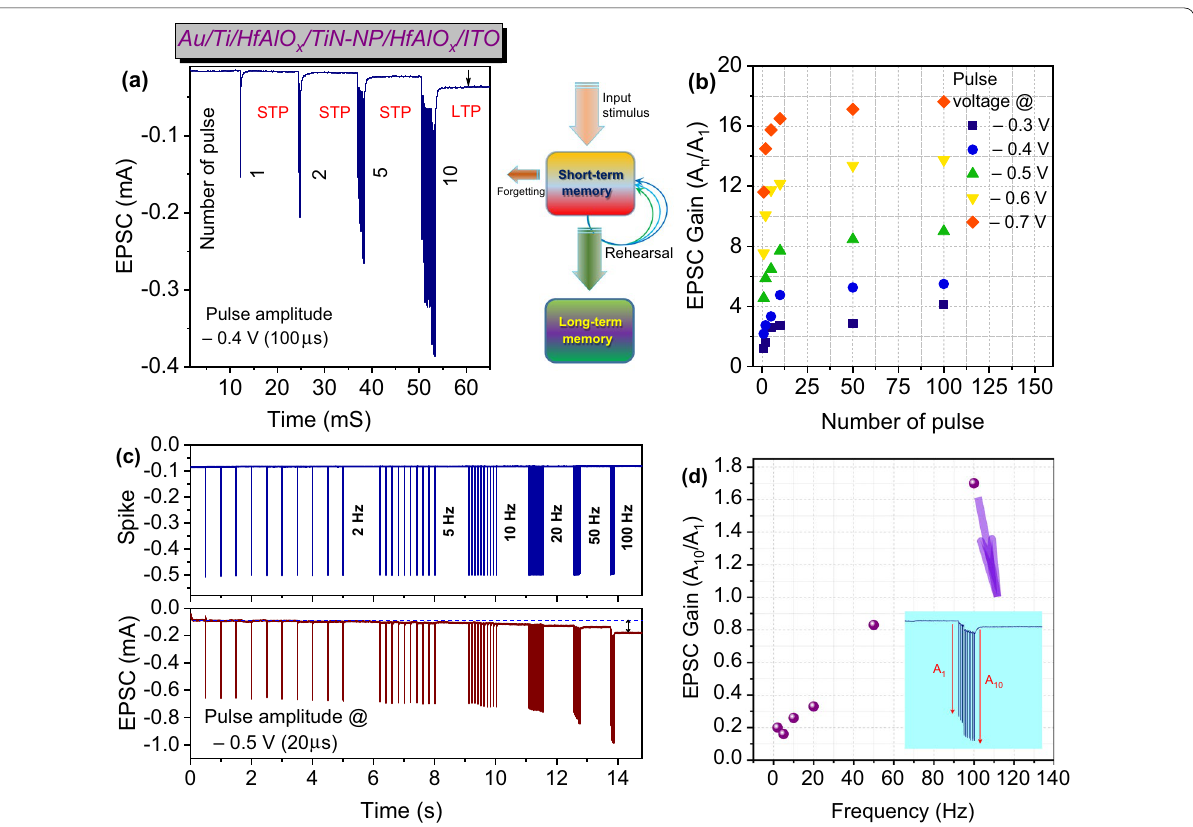
Fig. 4 a Transition from STM to LTM of Au/Ti/HfAlO x /TiN-NP/HfAlO x /ITO RRAM device with the change of EPSC varying the spike number from 1 to 10 at the pulse voltage amplitude of ‒ 0.4 V/100 µs, along with the schematic of memory enhancement by repeated pulses. b EPSC gain (A n /A 1 ) plotted w.r.t. the pulse number at different pulse voltage from ‒ 0.3 V/100 µs to ‒ 0.7/100 µs V. c Synaptic plasticity EPSC measured with frequency from 2 to 100 Hz and d the EPSC gain (A 10 /A 1 ) at pulse amplitude of ‒ 0.5 V/20